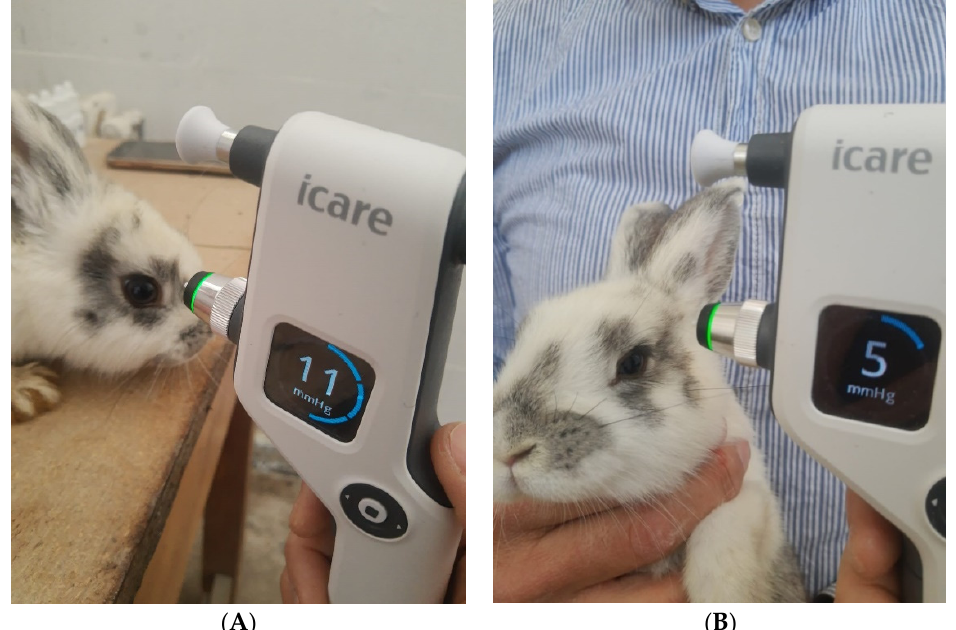
Figure 7. IOP measurement with the iCare non-contact tonometer for a rabbit from the LE4 group and its values after the administration of dexamethasone (15 days, ( A )) and after the administration of drugs encapsulated in micelles (15 days, ( B )).